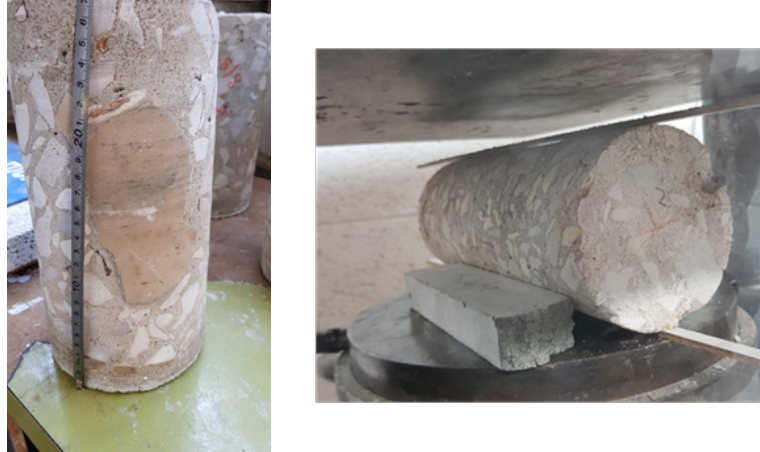
Figure 2. Cylindrical authentic LPC specimens. Table 3. Compressive strength of the authentic